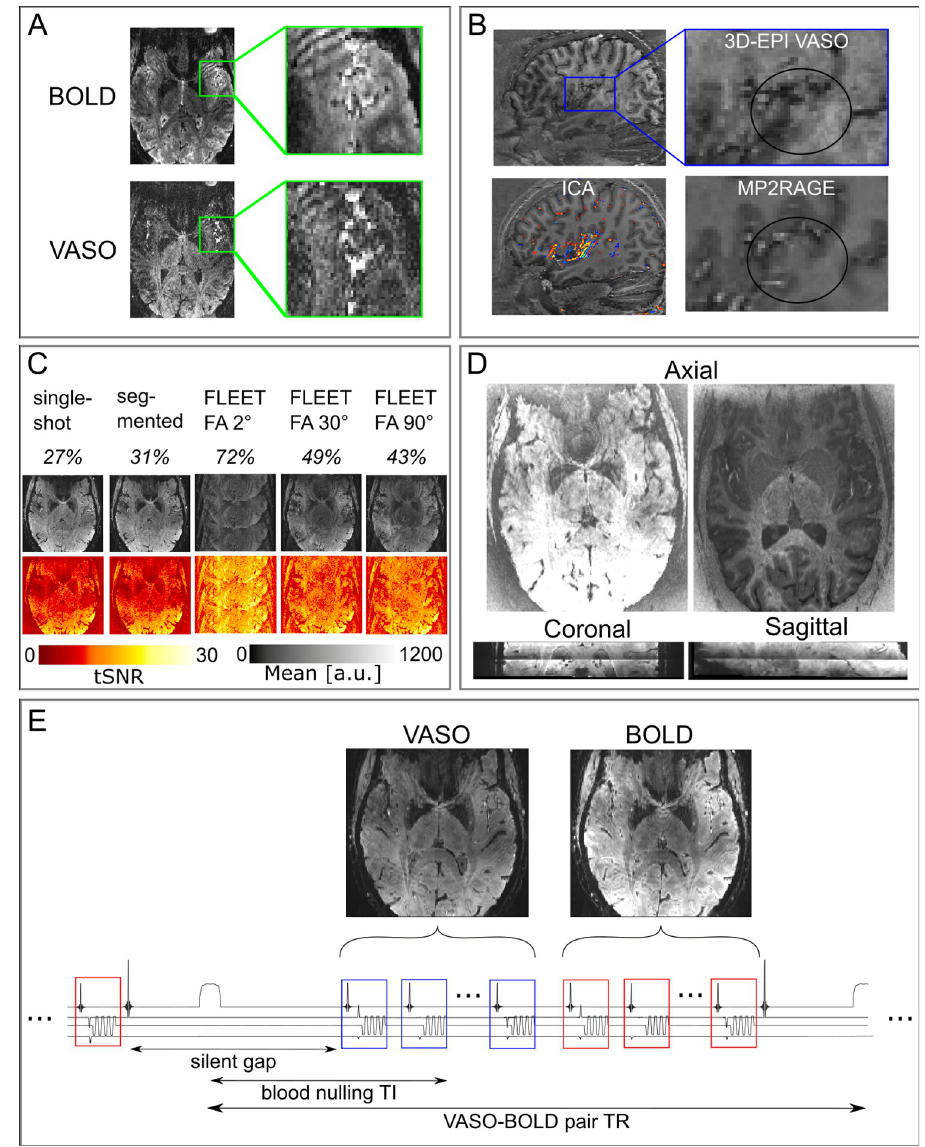
Fig 1. Overview of the challenges encountered when acquiring VASO data in the auditory cortex. (A) Inflow effects were found in both GE-BOLD and VASO in temporal regions. However, the VASO signal seemed to be more affected by the inflow of not-nulled blood. (B) Cardiac pulsation effects reduced image contrast due to long 3D-EPI readouts. In the functional images, the contrast in our region of interest seemed to be particularly affected. Additional ICA analysis (left bottom) showed the main components around Heschl’s gyrus. (C) In the presence of physiological noise, there is a tradeoff in the amount of ghosts and the tSNR when evaluating different GRAPPA auto calibration signal (ACS) acquisitions. The first row contains the percentage of background signal compared to signal in the auditory cortex. The second row gives an impression of the ghost level and the third row gives an illustration of the tSNR. These tests were conducted for the protocol with 2D-SMS readouts. (D) 2D-SMS VASO resulted in T1-weighted slice-wise intensity differences that were most visible in the middle of the slab. The two axial slices show the intensity differences between two “consecutive” slices (with the same signal intensity scaling). (E) Schematic depiction of one TR of the final SS-SI-VASO sequence. An inaudible phase-skipped adiabatic pulse is used in the inherent silent gap of this sequence. This is followed by the acquisition of a volume of VASO and a volume of